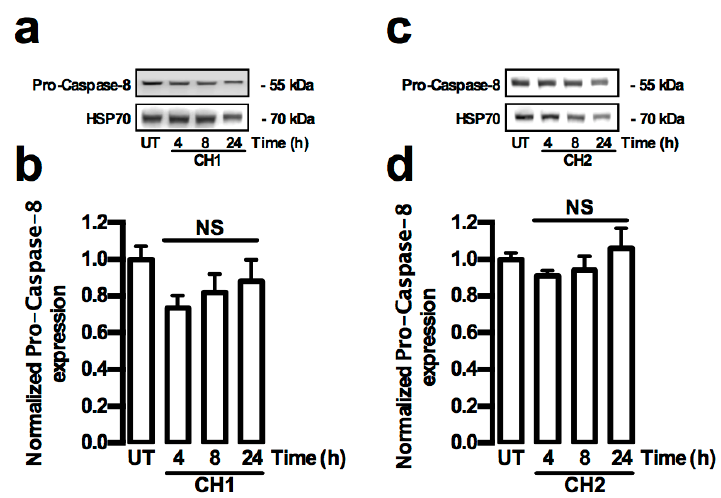
Figure 6. Chalcones do not induce caspase extrinsic pathway in HepG2 cells. ( a – d ) Cells were treated with CH1 and CH2 (50 μ M, each) and protein expression was analyzed. ( a , c ) Representative images from Western blot experiments performed for the detection of caspase-8; ( b , d ) Densitometric analyses of the experiments shown in ( a , c ), respectively. Protein levels were normalized against HSP70 and data are expressed relative to the UT (untreated) condition. Data are expressed as the mean ± standard error of the mean (SEM) from at least three independent experiments. Statistical differences were assessed by a one-way ANOVA (Kruskal–Wallis) followed by Dunn’s post hoc test. NS: Not significant.